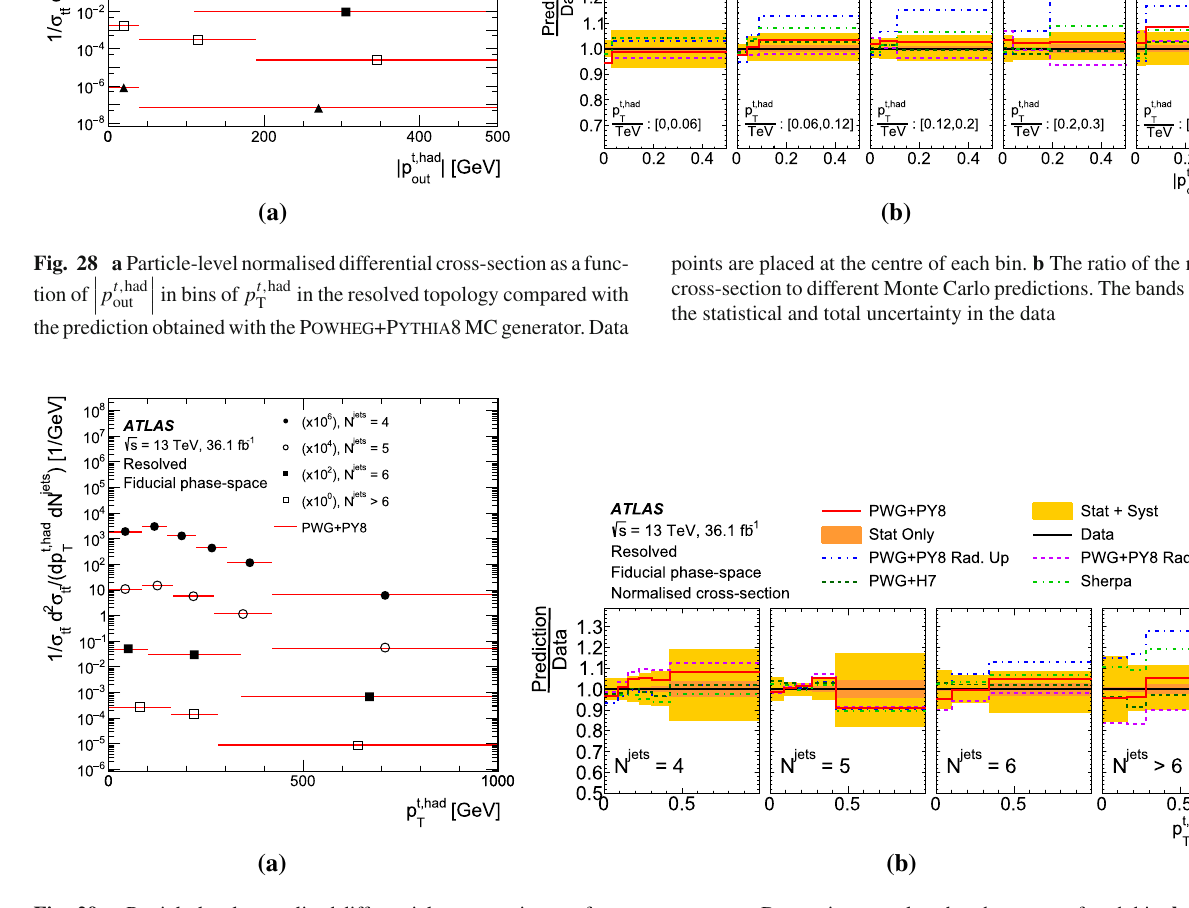
Fig. 29 a Particle-levelnormaliseddifferentialcross-sectionasafunc- tion of p t , had